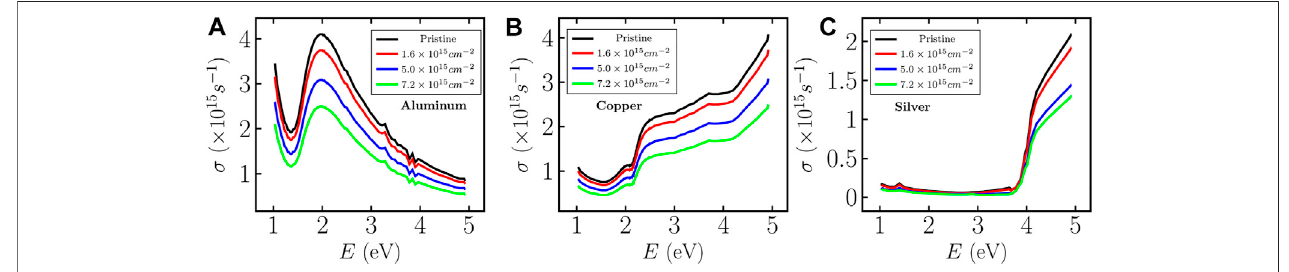
FIGURE 6 | Variation of optical conductivity for (A) aluminum, (B) copper, and (C) silver, respectively, with energy of incident light as well as varying fl uence of Argon